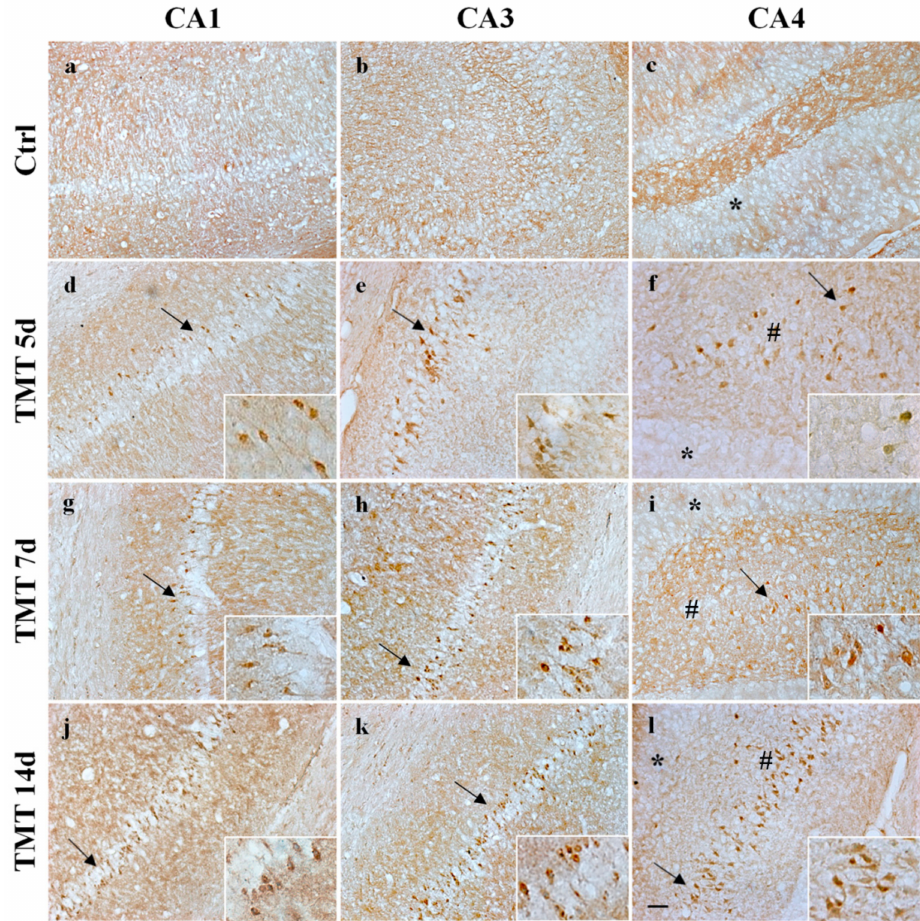
Figure 8. Immunohistochemical labeling of cleaved Caspase-3 in the rat hippocampus after TMT treatment is shown. Cleaved Caspase-3 was detected in brown staining (DAB) at 5 and 7 days in some neurons scattered in the CA1 ( d , g ), CA3 ( e , h ), and CA4 (# f , i ) areas and in numerous neurons at 14 days after treatment in the same regions (respectively j – l ). No active Caspase-3 immunoreactivity was observed in the control sections of CA1 ( a ), CA3 ( b ), and CA4 ( c ). No Caspase-3 in the granular neurons of the Dentate Gyrus (*) was observed at any time of treatment ( f , i , l ). Arrows and inserts show details. Scale bar: 50 µ m. Ctrl: control sample, d: days. For interpretation of the references to color in this figure legend, the reader is referred to the Web version of this